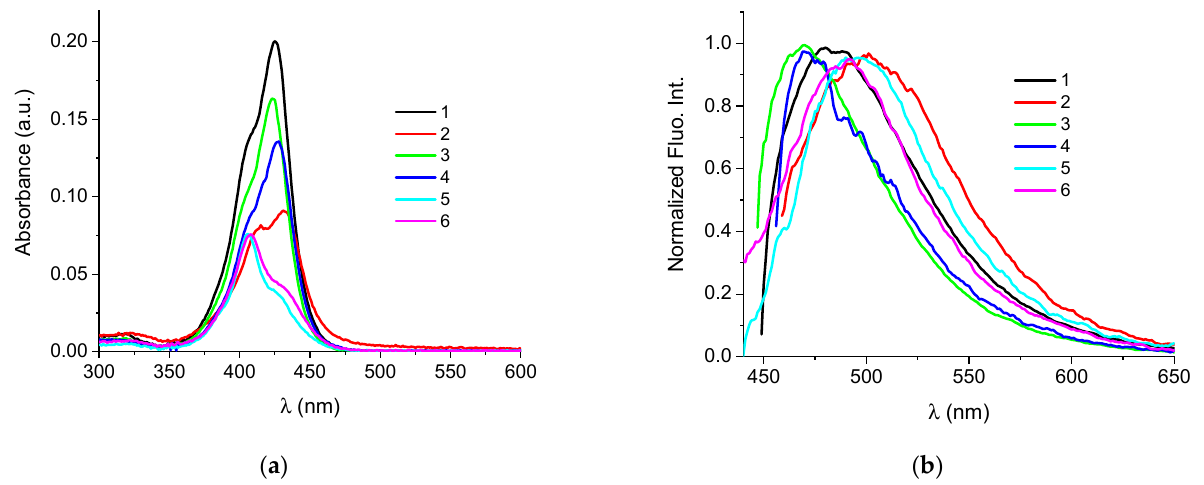
Figure 2. ( a ) UV Vis spectra of 1 to 6 at c = 2.39 × 10 − 7 mol dm − 3 , at pH = 7, sodium cacodylate buffer, I = 0.05 mol dm − 3 ; ( b ) Normalized spectra of 1 ( λ exc = 425 nm), 2 ( λ exc = 431 nm), 3 ( λ exc = 423 nm), 4 ( λ exc = 427 nm), 5 ( λ exc = 406 nm) and 6 ( λ exc = 407 nm), at pH = 7.0, sodium cacodylate buffer, I = 0.05 mol dm − 3 .